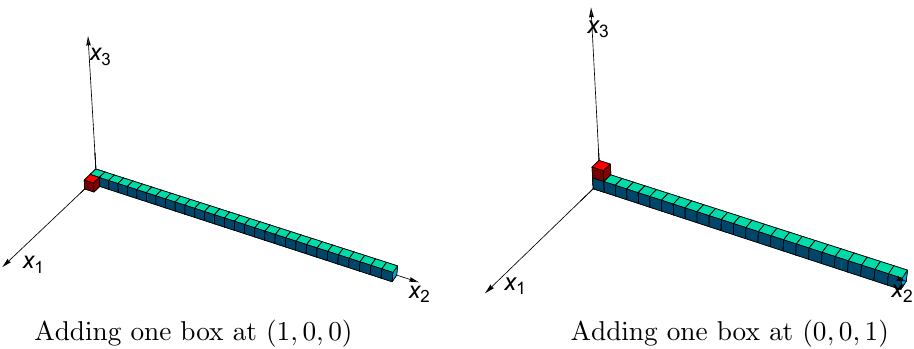
Figure 2 . The (cid:12)rst descendant states of the minimal